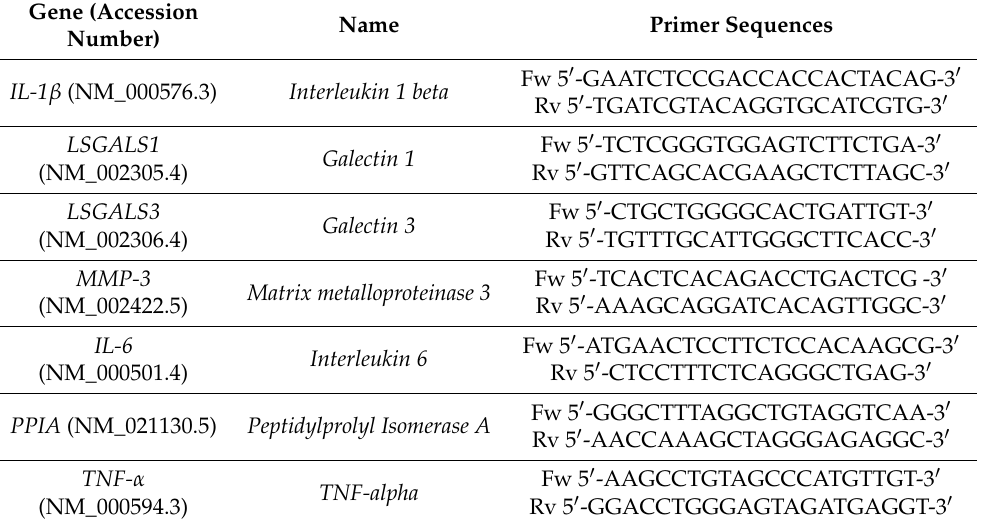
Table 1. Genes investigated and primers